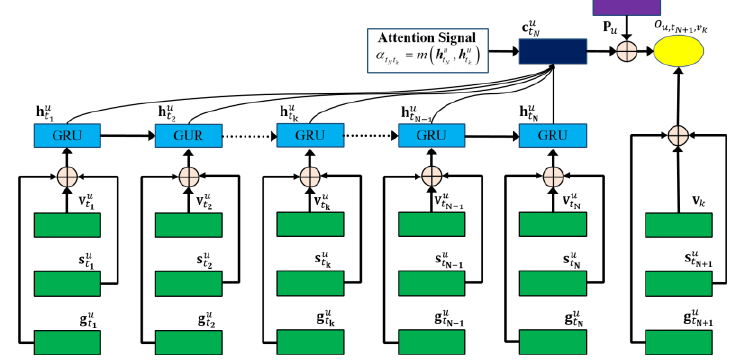
Figure 4. The architecture of attention-based spatiotemporal gated recurrent unit (ATST-GRU) network.